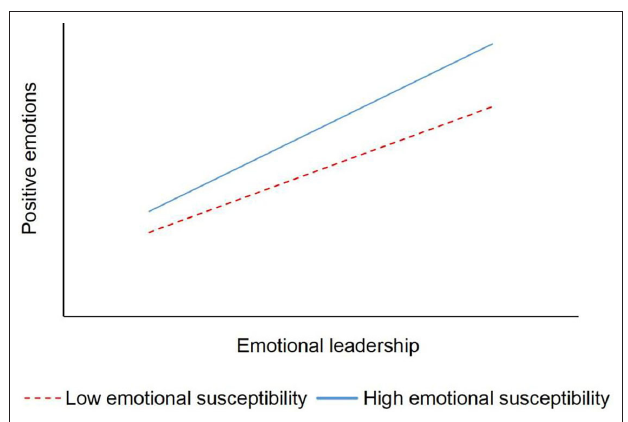
FIGURE 2 | The moderating effect of emotional